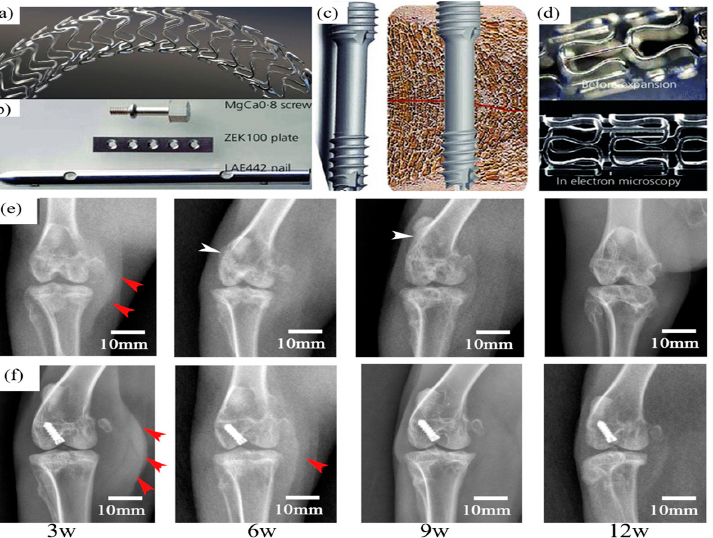
Figure 1. Real applications of biodegradable magnesium implants: ( a , d ) cardiovascular stents, ( b ) screws for orthopedic fixation, and ( c ) biodegradable orthopedic implants [8,9]; images of the rabbit knee joint in the anterior − posterior position at 3, 6, 9, and 12 weeks post − operation in ( e ) HP Mg group and ( f ) Ti group (red and white arrowheads indicate soft tissue swelling and periosteal reaction, respectively) [10]. Reprinted with permission from refs. [8–10]. Copyright 2022 Elsevier.